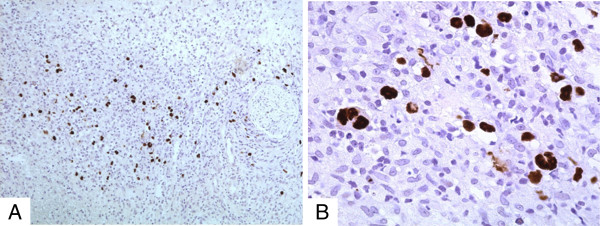
Epstein-Barr virus-encoded ribonucleic acidin situhybridization illustrates (A and B) positive nuclear reaction of the large atypical and Reed-Sternberg-like cells (×10 and x20; chromogenicin situhybridization stain).